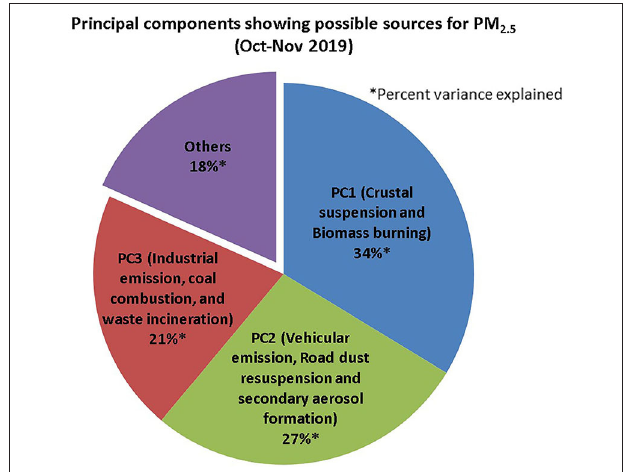
FIGURE 6 | Source-apportionment of PM 2.5 derived from PCA analysis during the post-monsoon (11 Oct − 20 Nov 2019)